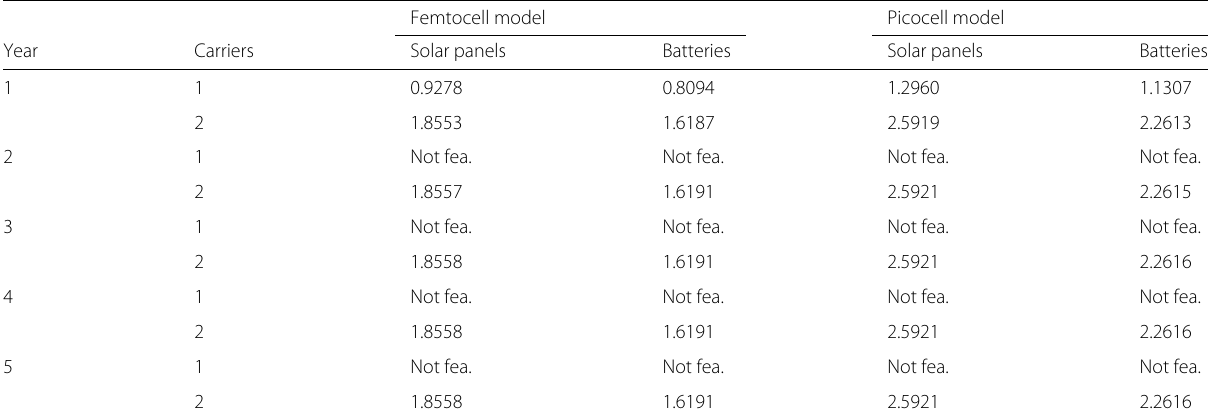
Table 5 Solar panels and batteries (San Gabriel) Femtocell model Picocell model Solar panels Batteries Solar panels